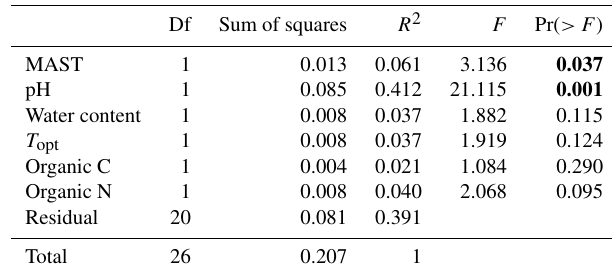
Table 3. Permutational multivariate analysis of variance (PER- MANOVA), showing the influence of mean annual soil temperature and other environmental factors on the weighted unique fraction metric (UniFrac) distance between 16 rRNA gene sequence from soil bacterial communities across the 11 sampled sites. Bold values indicate the significance ( P < 0 .